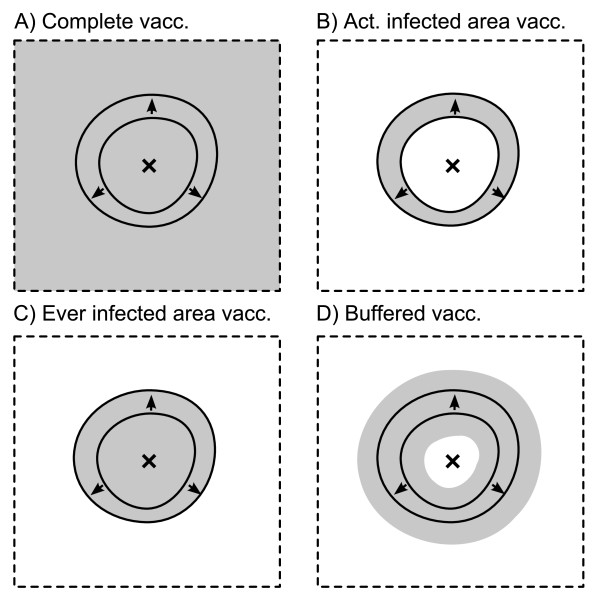
Schematic diagram of spatial vaccination strategies with infected area (solid outlines), baiting zone (grey fill), virus release point (cross) and disease spread direction (arrows). The circular pattern of infected areas is idealized from more distorted model outcomes.